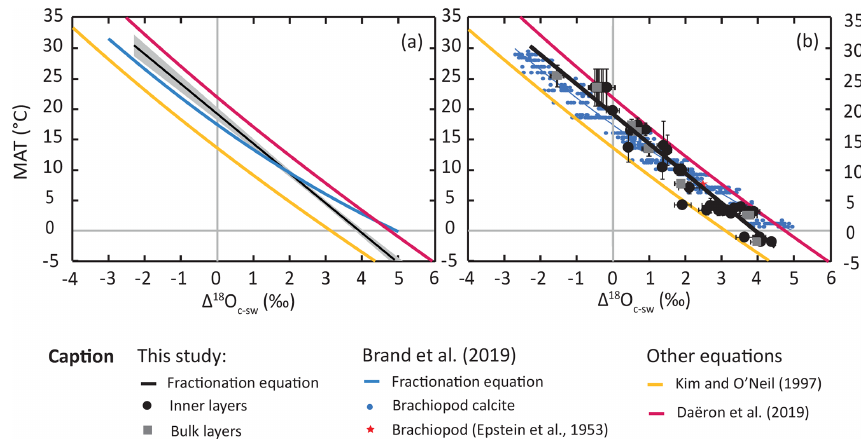
Figure 2. Plot comparison of (a) regression lines for different temperature–oxygen isotope fractionations for brachiopod calcite (this study; Brand et al., 2019), laboratory-precipitated calcite (Kim and O’Neil, 1997) and slow-growing cave calcite (Daëron et al., 2019); and (b) cor- responding datasets for brachiopod calcite (modified after Brand et al., 2019). Uncertainty envelope of 95% CI of the York least-squares regression (York et al., 2004).